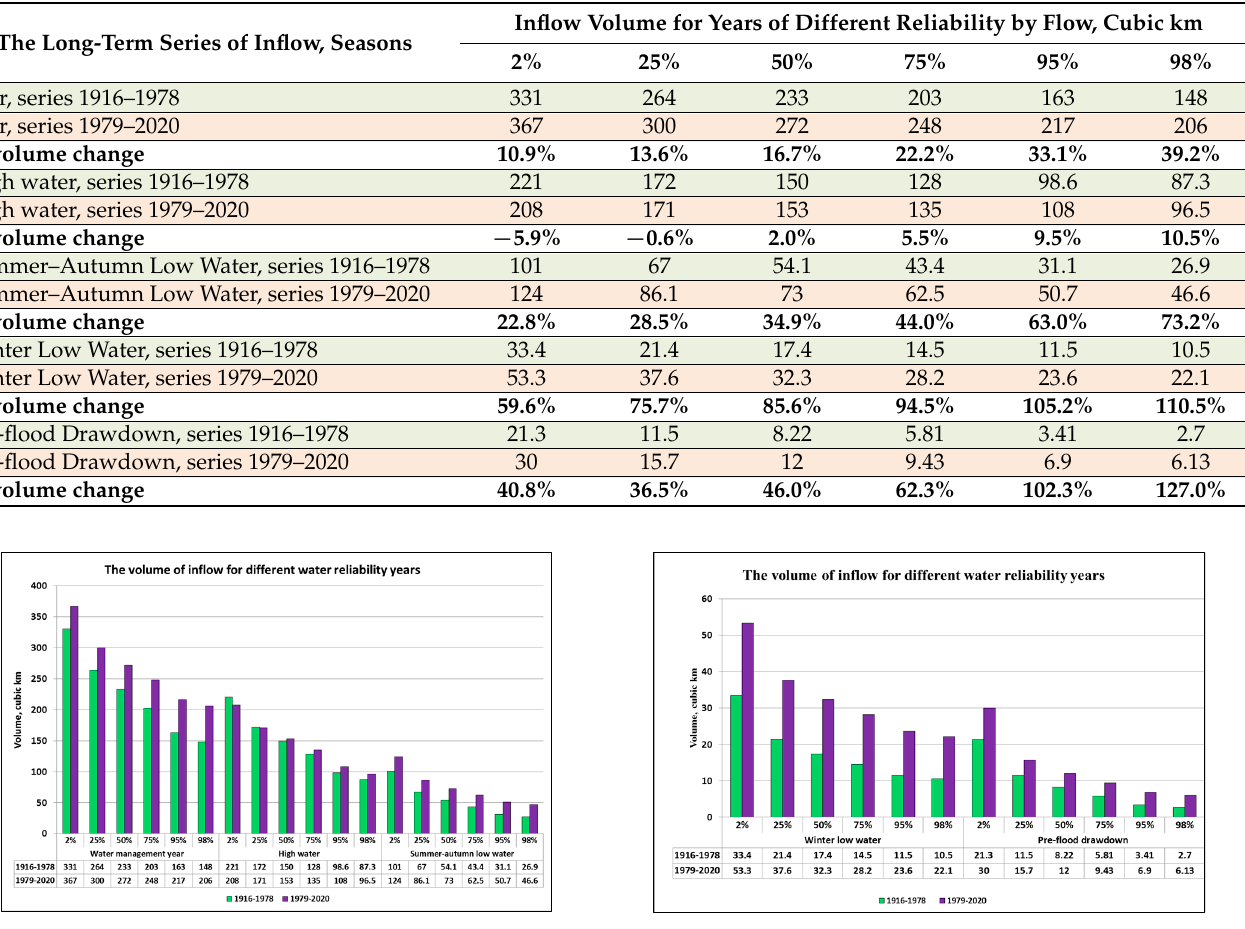
Figure 10. The volume of in fl ow for two long-term series by seasons and years of di ff erent reliability by in fl ow.